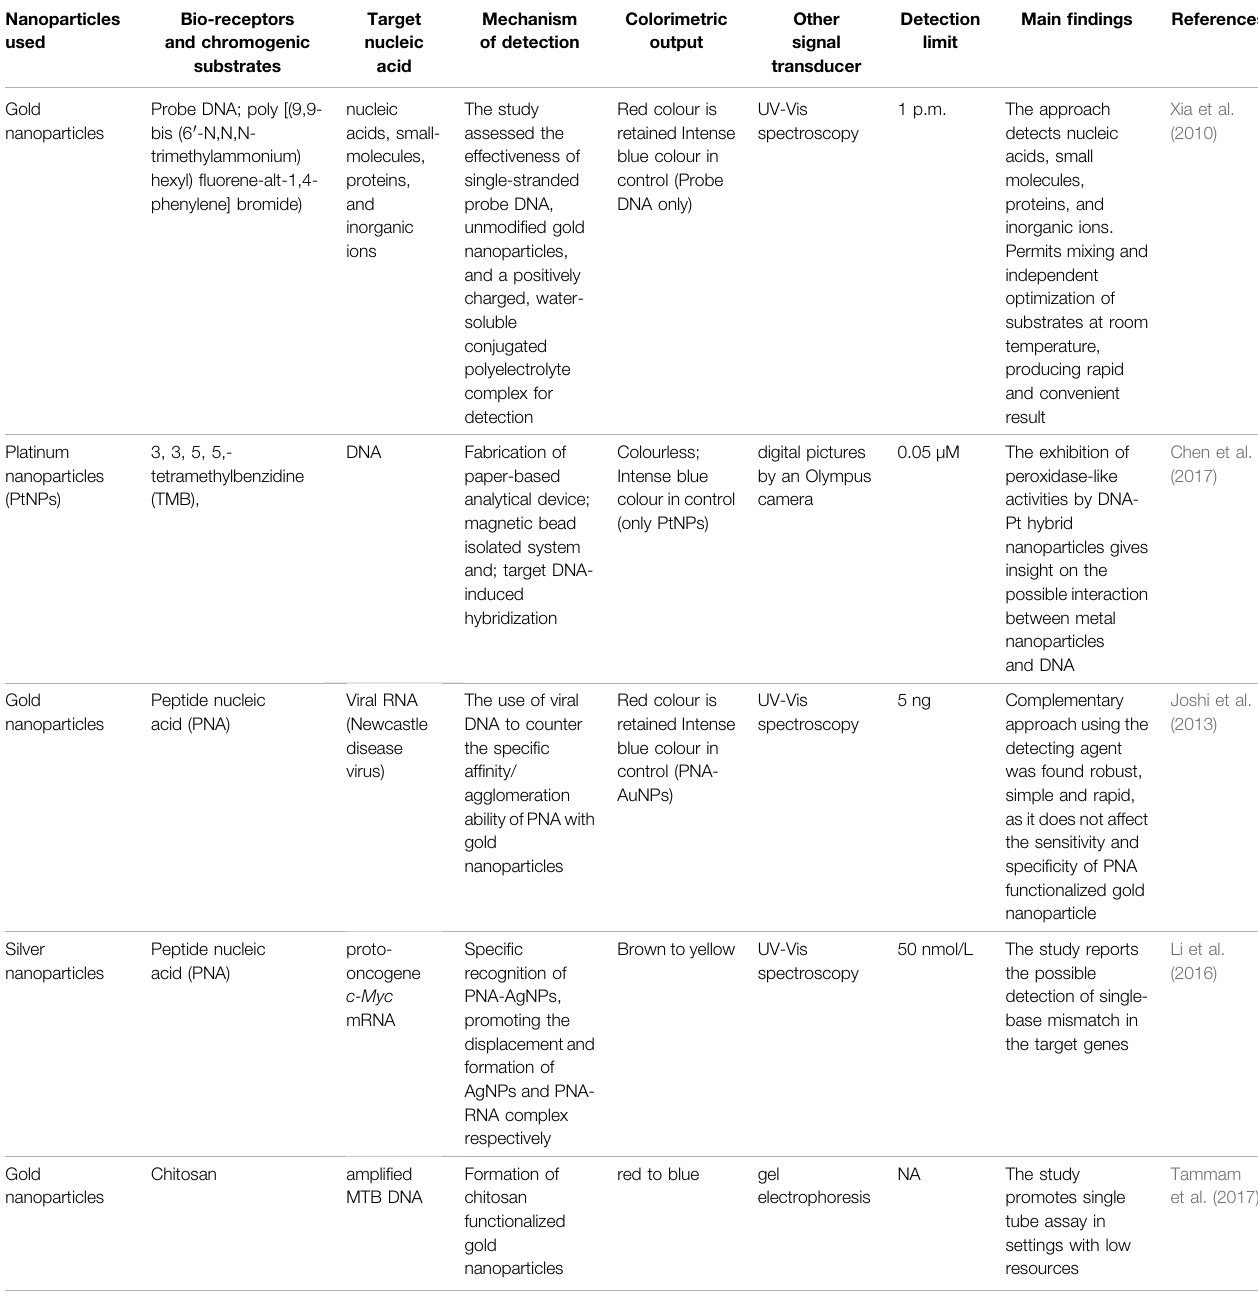
TABLE 1 | Summary of studies that have applied bio-receptors and chromogenic substrates for the detection of nucleic